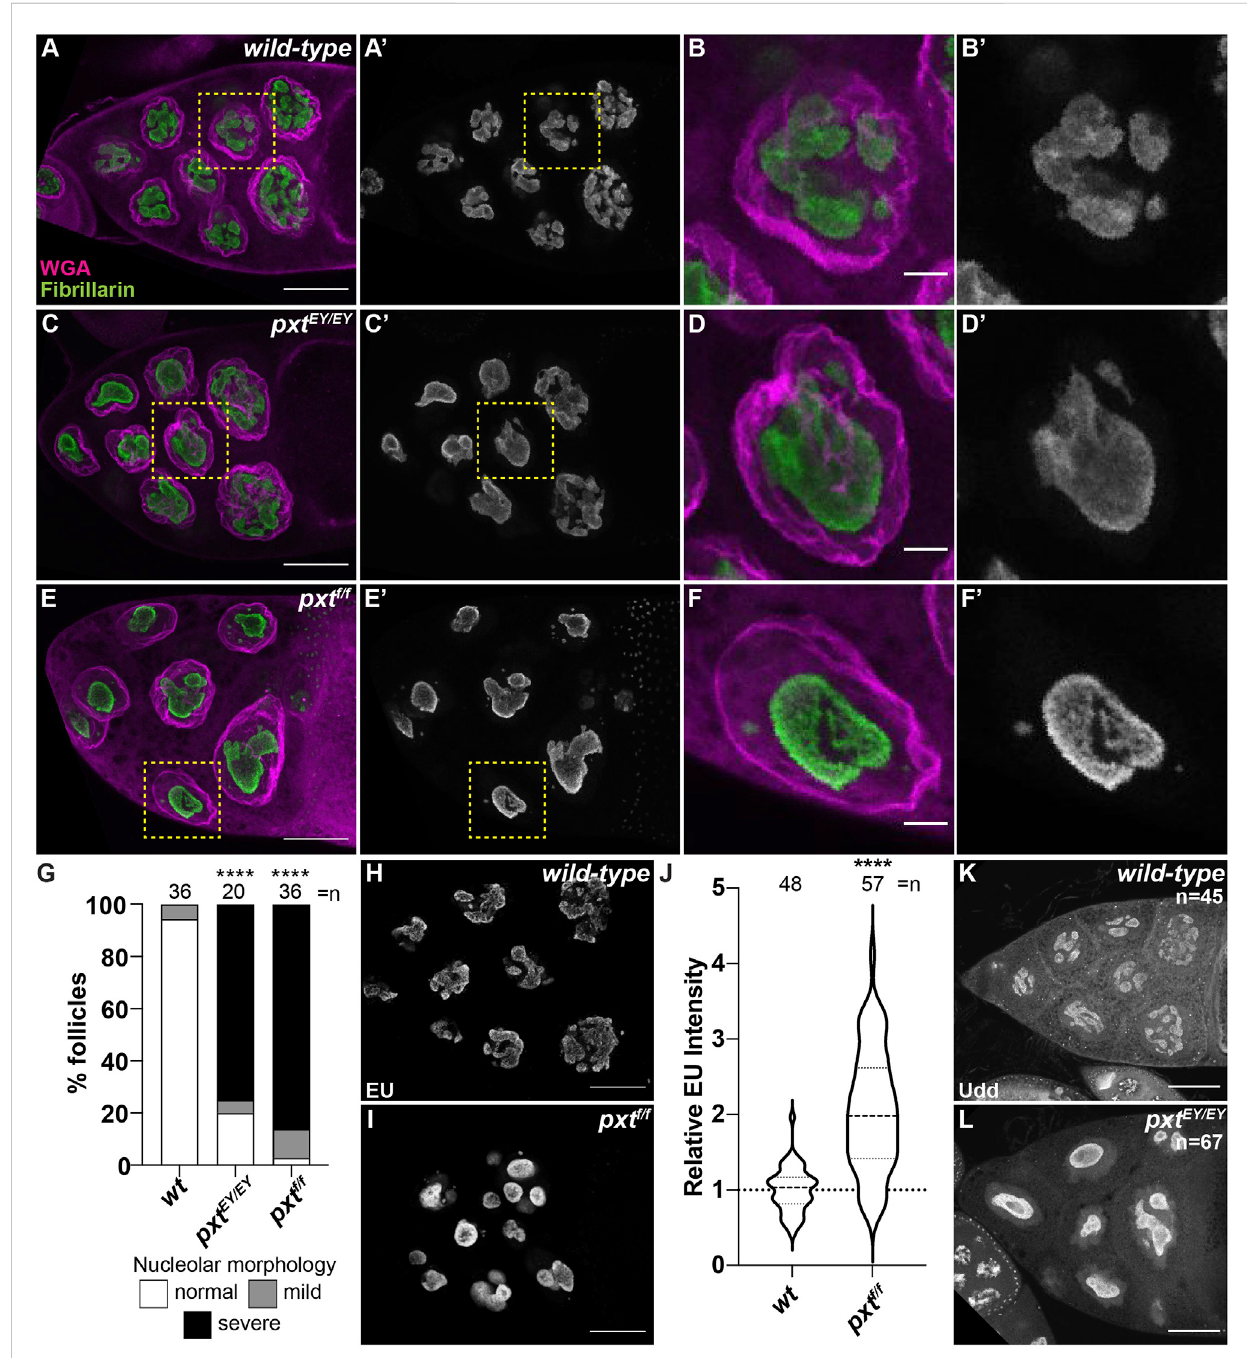
FIGURE 1 Prostaglandins regulate nucleolar structure and limit rRNA transcription. (A – F 9 ), (H,I,K,L) . Maximum projections of 2-4 confocal slices of wild-type ( yw )and pxt mutant( pxt EY/EY and pxt f/f asindicated)S10Bfolliclesstainedfor:nucleolus(Fibrillarin,greeninmergeandwhiteinsinglechannel)andnuclear envelopewheatgermagglutinin(WGA),magentainmerge)in (A – F 9 ) ,nascentRNA(EU)in (H,I) ,andUdd,aRNAPIregulatorycomplexcomponentin (K,L) . Yellow boxed regions in (A, C, E) are shown as zoomed in images in (B-B 9 , D-D 9 , F-F 9 ) , respectively. Scale bars = 50 μ m except in (B-B 9 , D-D 9 , F-F 9 ) where scale bars = 10 μ m. (G) . Graph quantifying the percentage of follicles exhibiting normal (white) vs. mild (gray) or severe (black) defects in nucleolar morphology. (J) . Graph of quanti fi cation of relative EU intensity. **** p < 0.0001 (unpaired t-test). n = number of follicles. Loss of Pxt results in a rounded nucleolar morphology (A – G) , increased nascent nucleolar RNA (H – J) , and normal nucleolar localization of Udd (K,L)